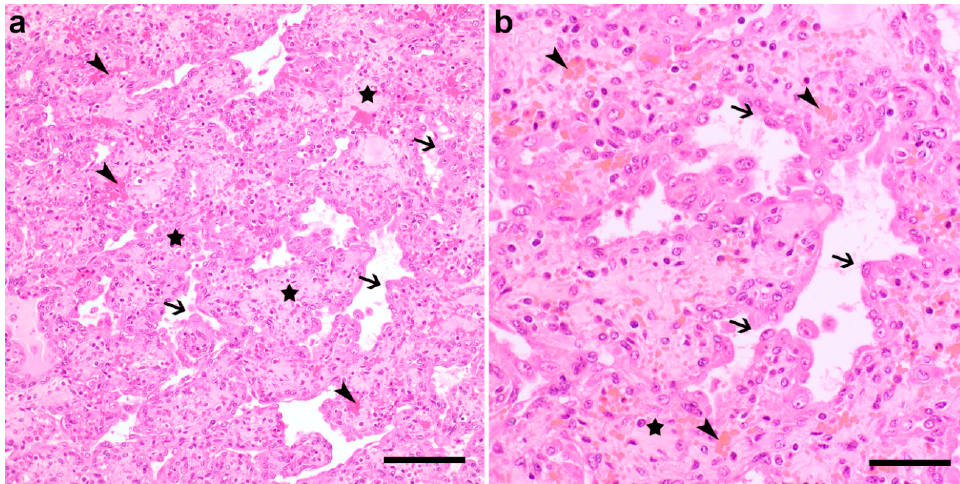
Figure 2. Histology of one of the subcutaneous nodules from the Bovine juvenile angiomatosis (BJA)-affected Simmental calf. Note the variably sized, mostly empty cavities lined by a single layer of plump cells (arrows) and supported by a loose fibrovascular stroma (stars) with occasional acute hemorrhage (arrowheads). Hematoxylin and eosin (H&E) staining, Bar 100 µm ( a ) and 50 µm ( b ).